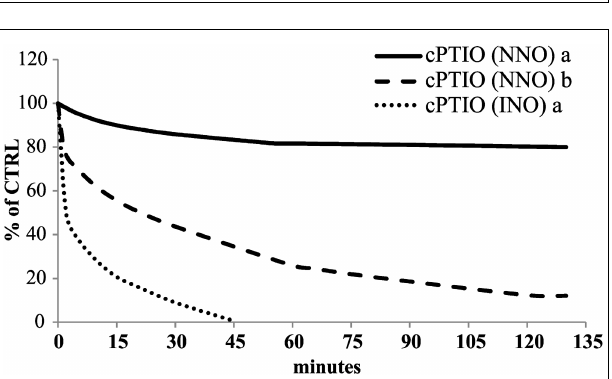
FIGURE 6 |Time dependence of cPTIO EPR signals in Arabidopsis total soluble extract. 100 μ M cPTIO(NNO) or (INO) was incubated in 50 mM PBS pH 7 in the presence of a protein concentration of (a) 0.3 mg/ml or (b) 1.8 mg/ml Arabidopsis total extract.The time course of the reactions was followed as decrease of the EPR signals.The EPR signals for each measurement were presented as percentage of the total signal resulting from measurement of 100 μ M cPTIO dissolved in PBS.The plot reported is representative of three independent